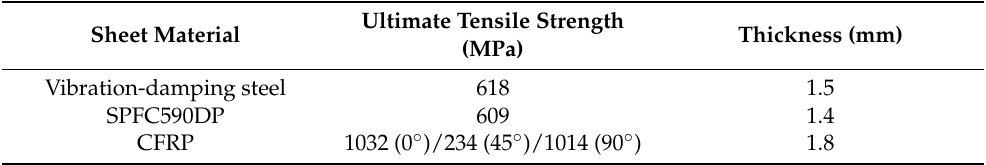
Table 2. The tensile strength and the thickness of the materials used in this study.